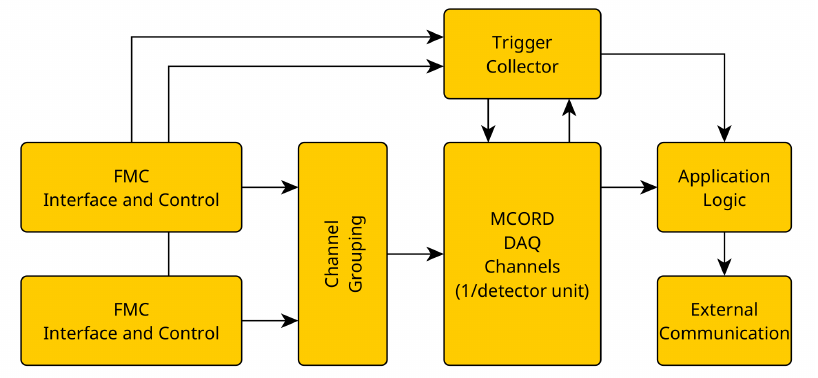
Figure 33. General overview of MCORD DAQ Firmware for single-carrier